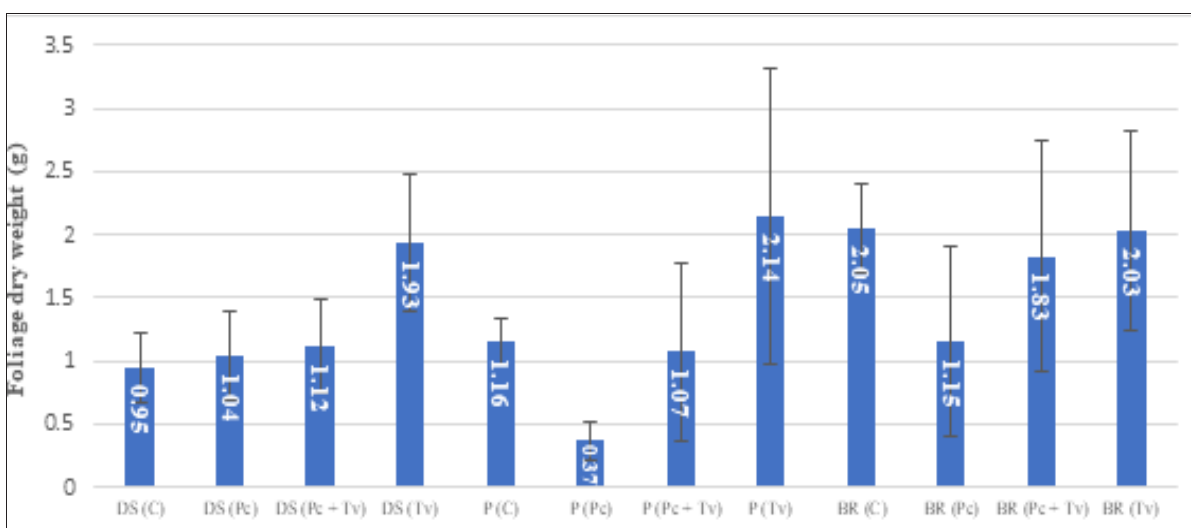
Figure 2. Foliage dry weight (g), according control treatments of P. capsici on T. viride under three sowing methods ( α = 0.05).